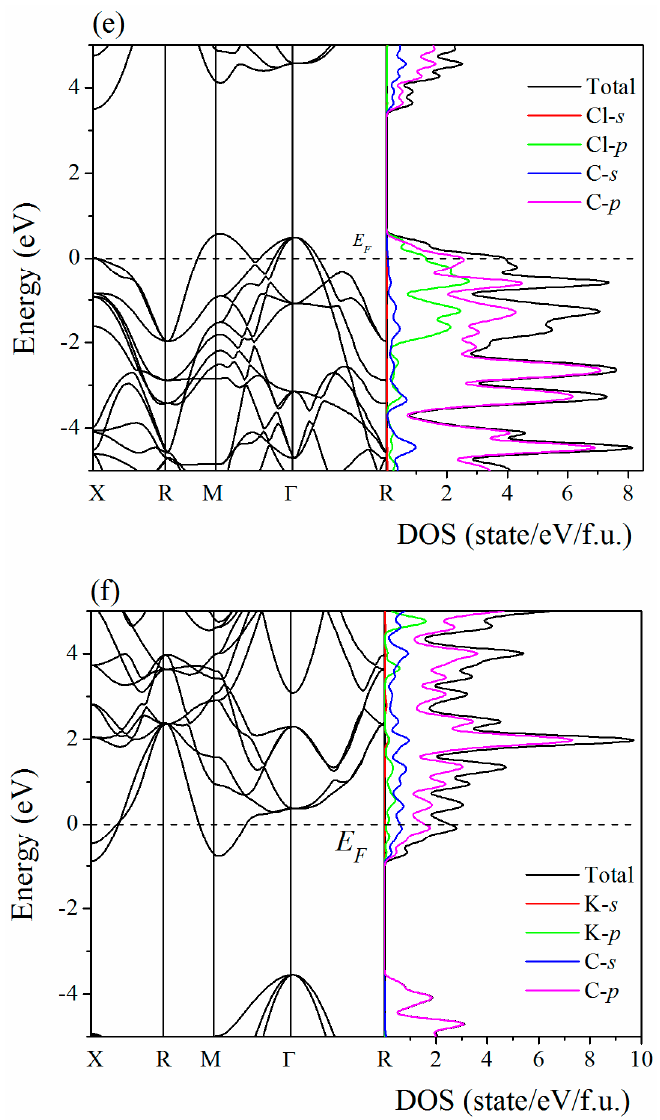
Figure 8. Electronic band structure and density of state of BC 12 ( a ); CC 12 ( b ); PC 12 ( c ); SC 12 ( d ); ClC 12 ( e ); and KC 12 ( f ).